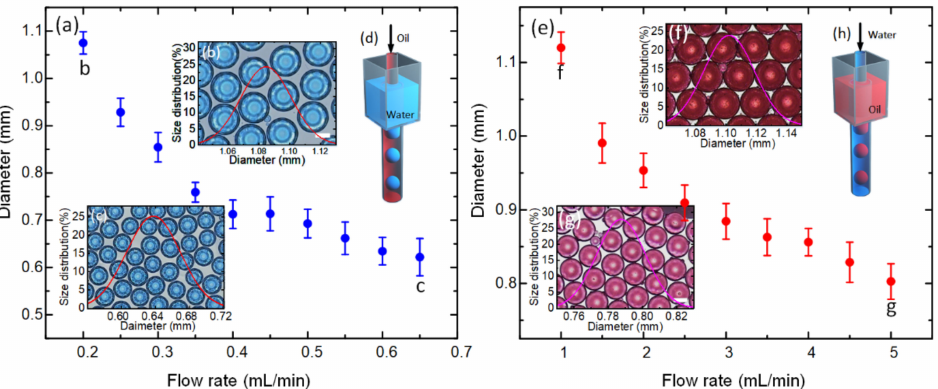
Figure 4. Formation of aqueous and oil microdroplets in the SPFM device: ( a ) relationship between the diameter of aqueous droplets and the flow rate of aqueous fluid; ( b ) images of monodispersed microdroplets prepared at 0.2 mL/min; the scale bar is 500 µ m; ( c ) images of monodispersed microdroplets prepared at 0.65 mL/min; the scale bar is 500 µ m; ( d ) schematic diagram of the formation of aqueous microdroplets in the SPFM device; ( e ) relationship between the diameter of oil droplets and the flow rate of oil fluid; ( f ) images of monodispersed microdroplets prepared at 1 mL/min; the scale bar is 500 µ m; ( g ) images of monodispersed microdroplets prepared at 5 mL/min; the scale bar is 500 µ m; ( h ) schematic diagram of the formation of oil microdroplets in the SPFM device.